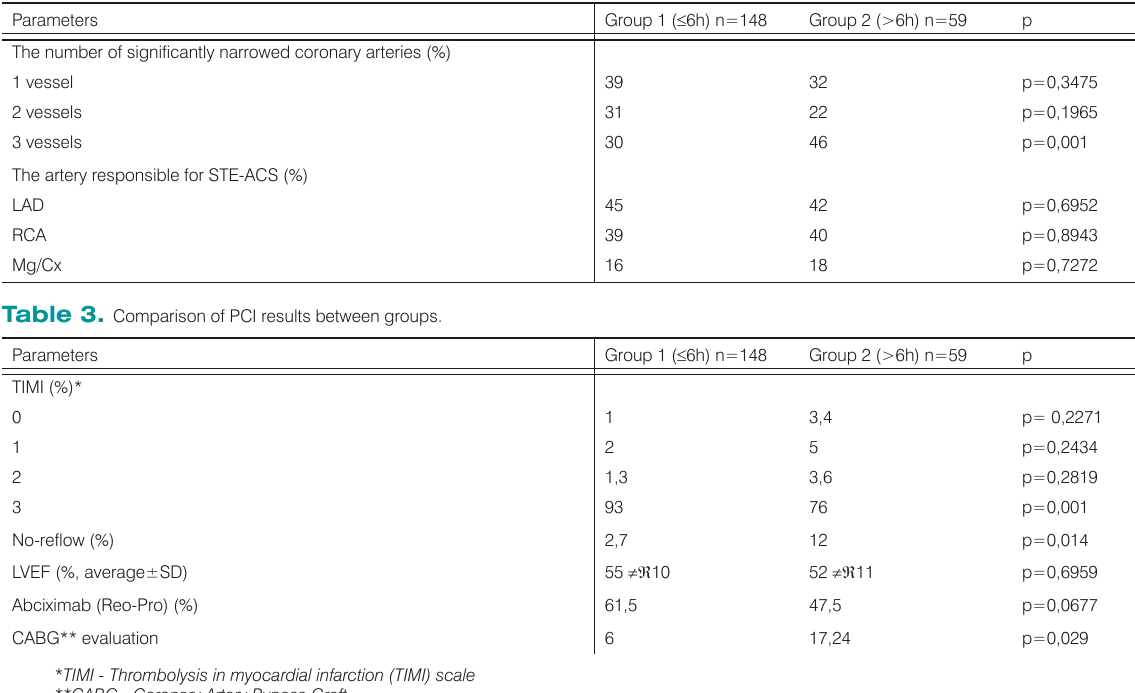
Table 2. Angiographic characteristics of the patients.